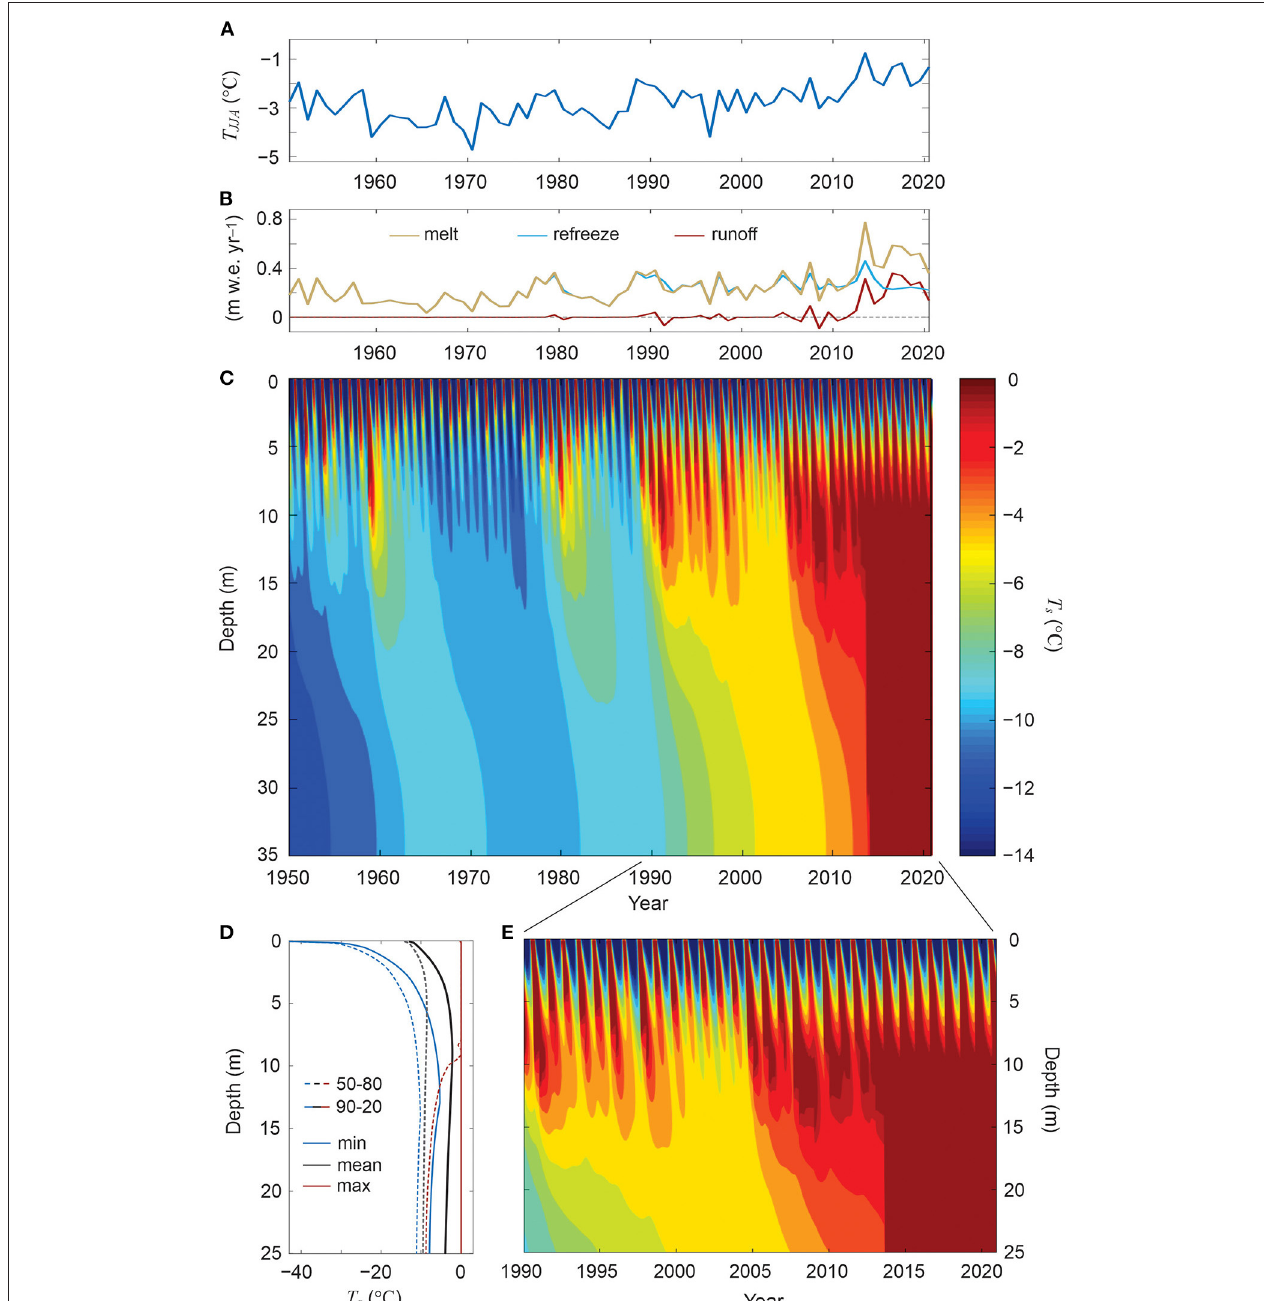
FIGURE 2 | Modelled temperate firn development at Kaskawulsh Glacier, Yukon Territory over the period 1950–2020. (A) Mean summer air temperature in the ERA5 climate forcing. (B) Annual melt, refreezing, and runoff. Runoff is calculated from the annual melt minus refreezing. (C) Firn temperatures to 35m depth. (D) Firn temperatures in the upper 25m, 1990–2020 (E) Firn temperature envelope in the upper 25m for the periods 1950–1980 (dashed) and 1990–2020 (solid lines). “Negative” runoff in (B) occurs when meltwater drainage to the deep firn from the prior summer refreezes in the subsequent calendar